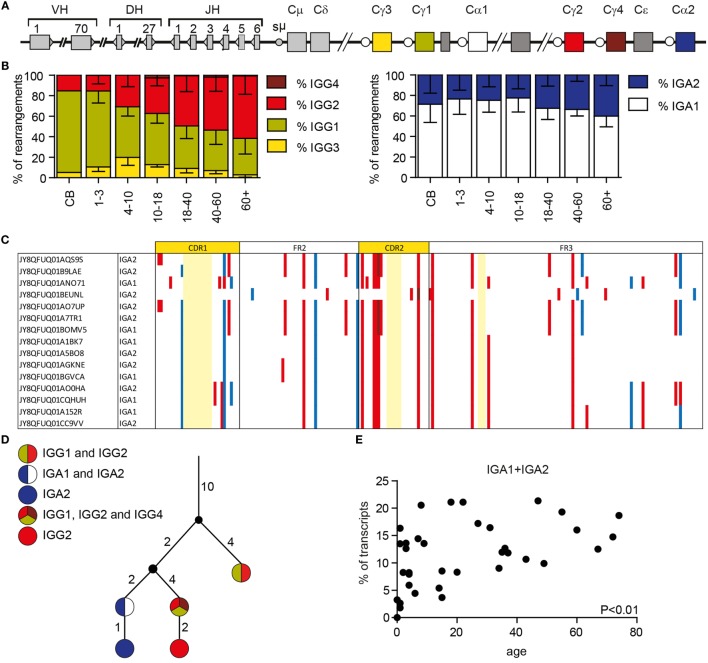
Class-switching and clonal relationship in HD. (A) A schematic overview of the IGH locus. (B) The subclass distribution of IGG and IGA transcripts changes with age. (C) Visualization of silent (blue) and replacement (red) mutations in clonal-related sequences. Numbering is based on the IMGT ontology. Bases not present in the clone are marked light yellow. (D) Lineage tree of clonal-related sequences found in a single sample based on a minimal substitution model. The small black circles represent inferred sequences not found in our data set. The numbers next to the branches correspond to the number of mutations that occurred between the different sequences. (E) The percentage of IGA sequences with the exact same CDR1-CDR3 sequences that are found as both IGA1 and IGA2 transcripts correlate with age. (F) The percentage of IGG sequences that overlap between the different IGG subclasses in HD of different ages. P-values are calculated using a Pearson correlation test.